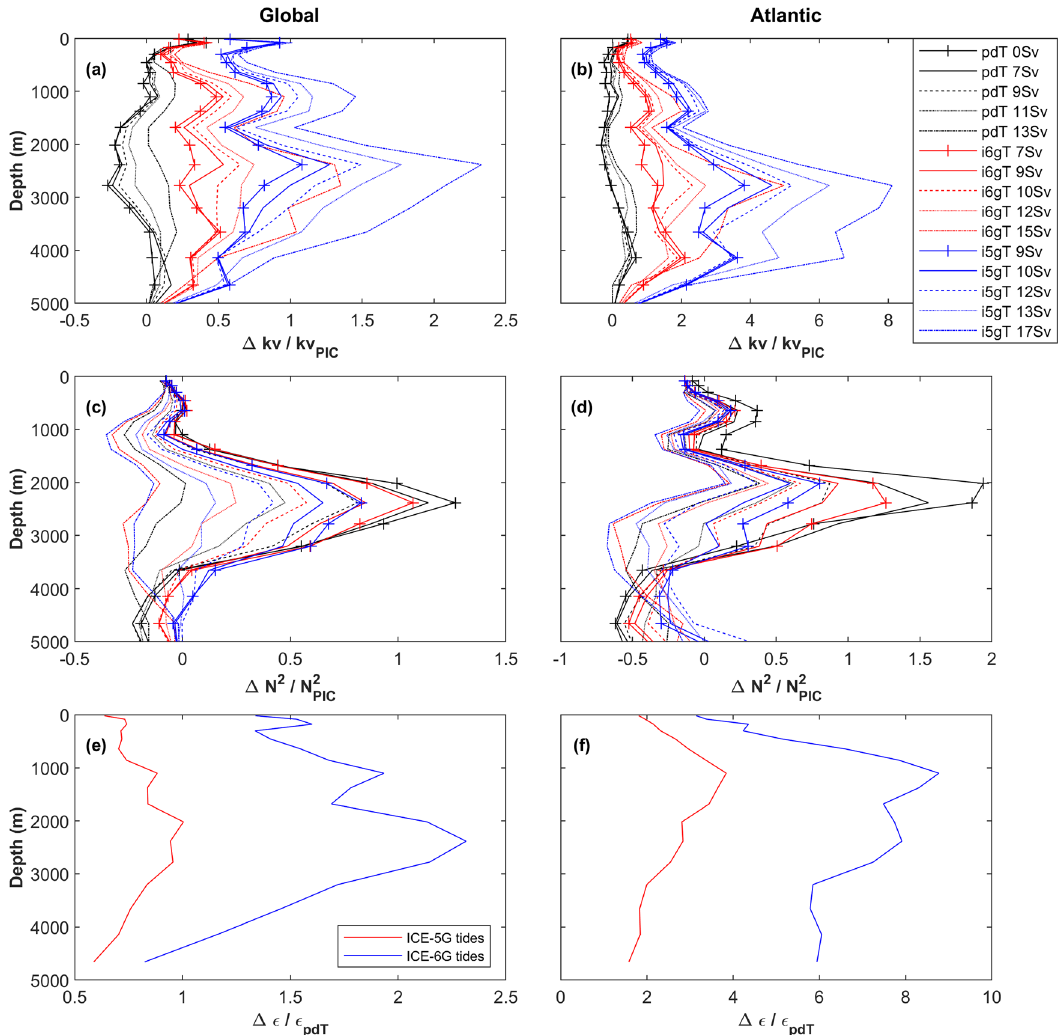
Fig. 3 Changes in vertical diffusivities, strati fi cation, and turbulent energy dissipation. (right) Global and (left) Atlantic relative changes with respect to the preindustrial control (PIC) of ( a ) and ( b ) diapycnal diffusivities k v , ( c ) and ( d ) strati fi cation N 2 for the simulation ensemble. ( e ) and ( f ) relative changes in turbulent energy dissipation ϵ for ICE-6G and ICE-5G tides with respect to present-day (pd)